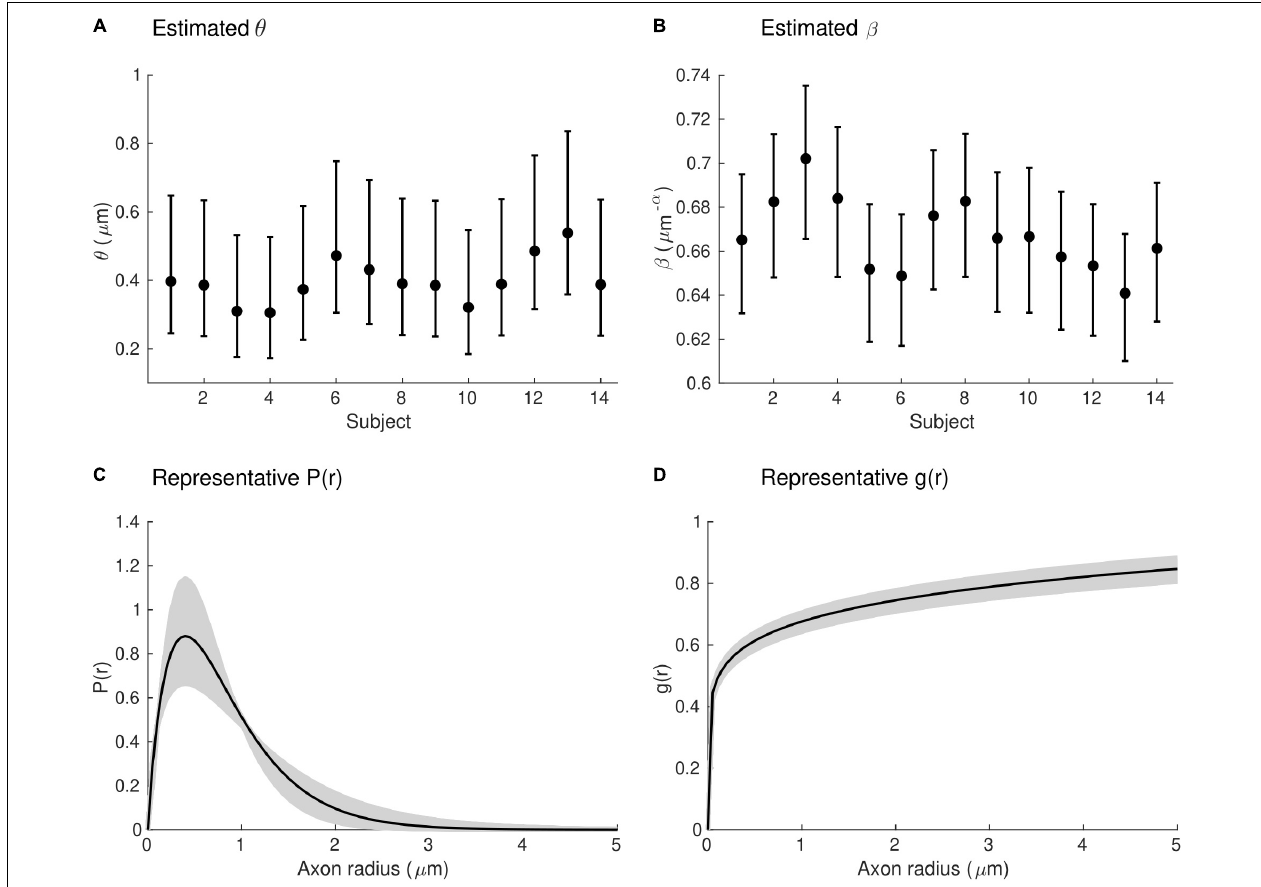
FIGURE 9 | Estimates of axonal morphology obtained from the in vivo g MRI and IHTT samples. (A) Estimates of the model parameter θ — the width of the right tail of the axonal radius distribution — in the visual transcallosal tract across all study participants. (B) Estimates of the model parameter θ — the scaling factor of the axonal g-ratio — in the visual transcallosal tract across all study participants. The error bars indicate the confidence intervals on the parameter estimates. (C) Exemplar axonal radius distribution in the visual transcallosal tract for a representative subject ( θ = 0.43 µ m; confidence interval: 0.27–0.69 µ m, shaded area). (D) Exemplar dependence of the fiber g-ratio on the axonal radius for the same subject ( β = 0.68 µ m − α , confidence interval: 0.64–0.71 µ m − α , shaded